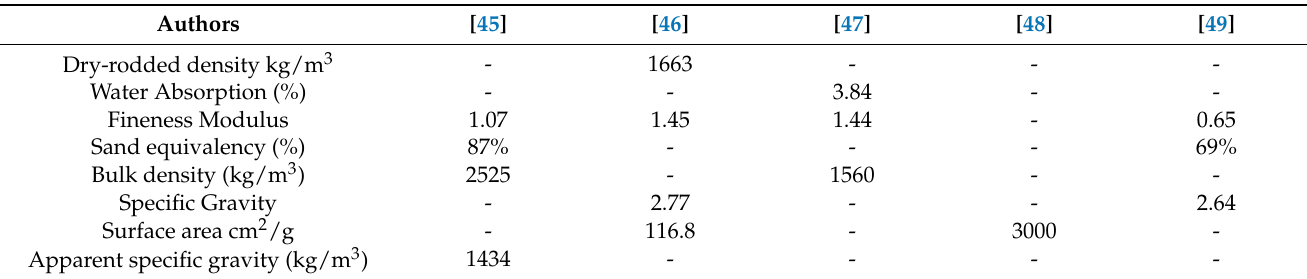
Table 1. Physical properties of dune sand.